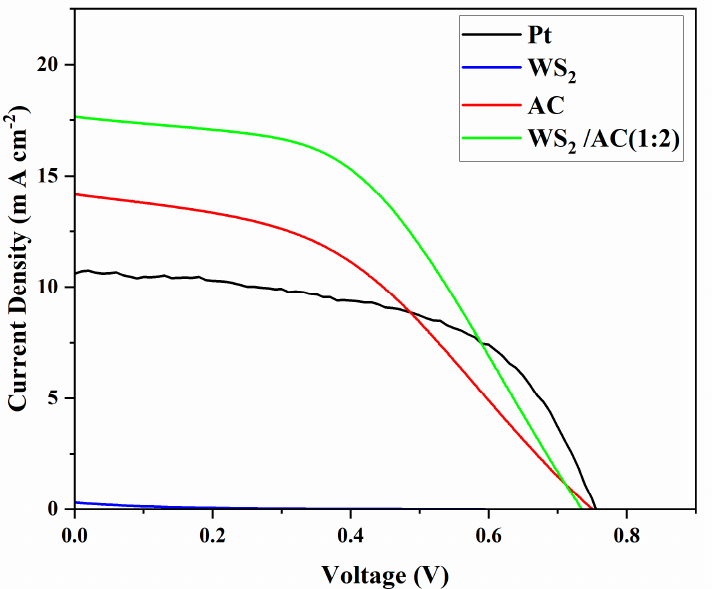
Figure 4. Current-voltage characteristics of the DSSCs assembled with different counter electrodes (WS 2 , AC, WS 2 /AC, and Pt), measured under AM 1.5 solar simulator with 100 mW cm -2 illumination.